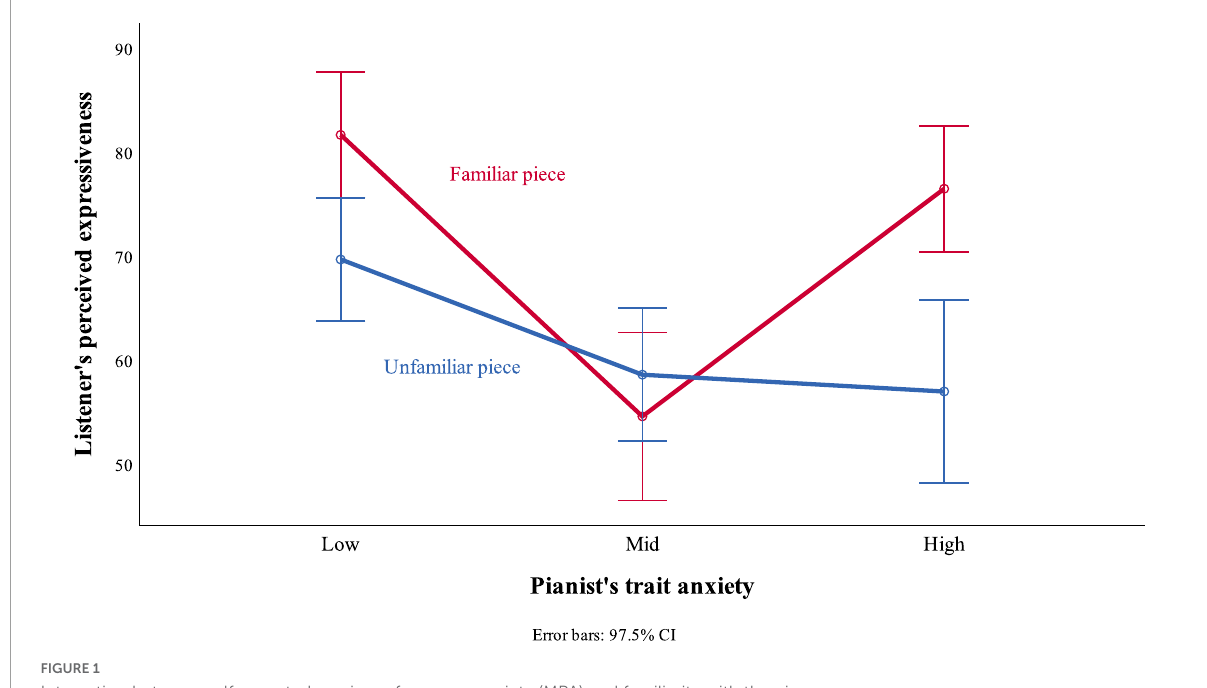
FIGURE1 Interaction between self-reported music performance anxiety (MPA) and familiarity with the piece.